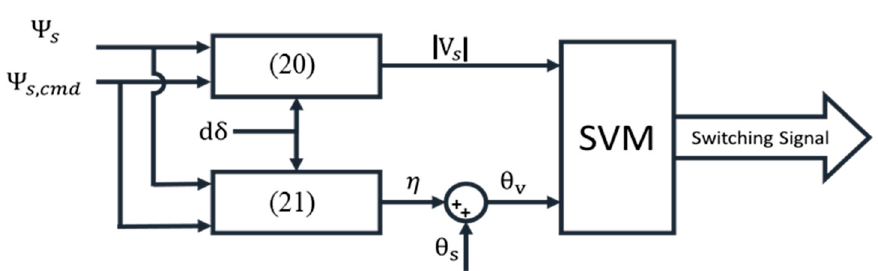
Figure 5. Architecture of the proposed method, rSVM-DTC. Ψ s , cmd here is Ψ (cid:48) s .